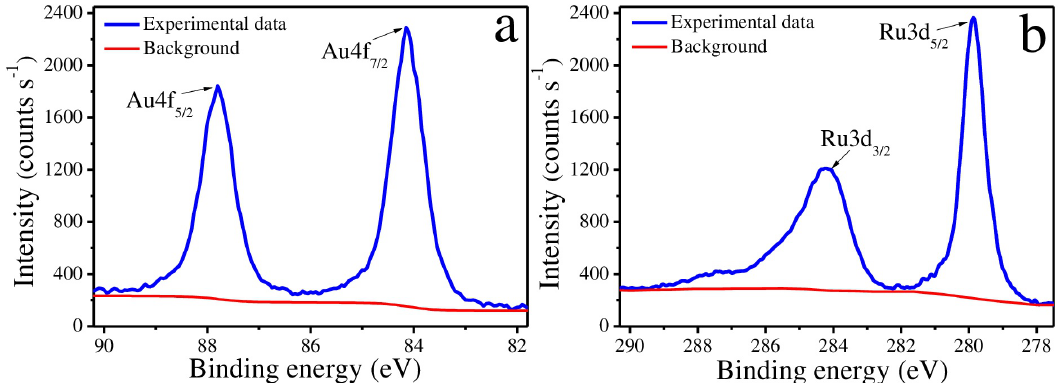
Figure 3. ( a ) Au4f and ( b ) Ru3d regions from XPS analysis of Au–Ru composite. The electrochemical properties of Au–Ru composite were studied using methods of cyclic (CV) and differential pulse (DPV) voltammetry, as well as direct amperometry (Figure